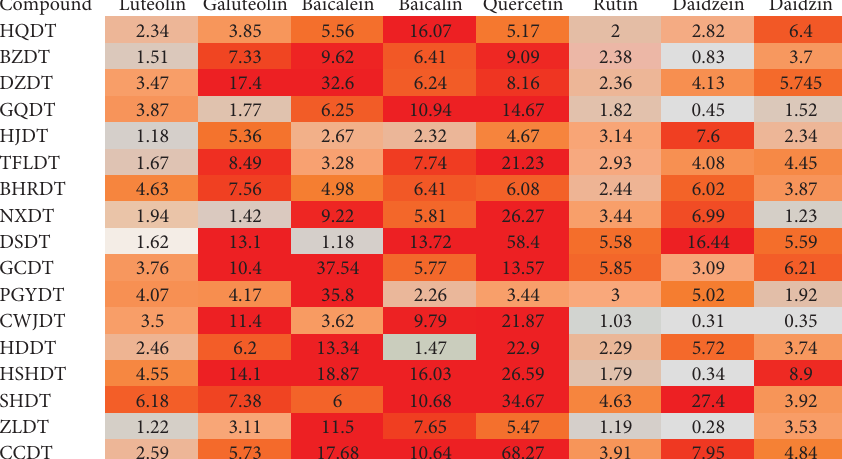
Figure 2: Heat map showing the effect of polysaccharides on the solubility of flavonoids. The ratio of the solubility with each polysaccharide present to the water-solubility of the flavonoid is